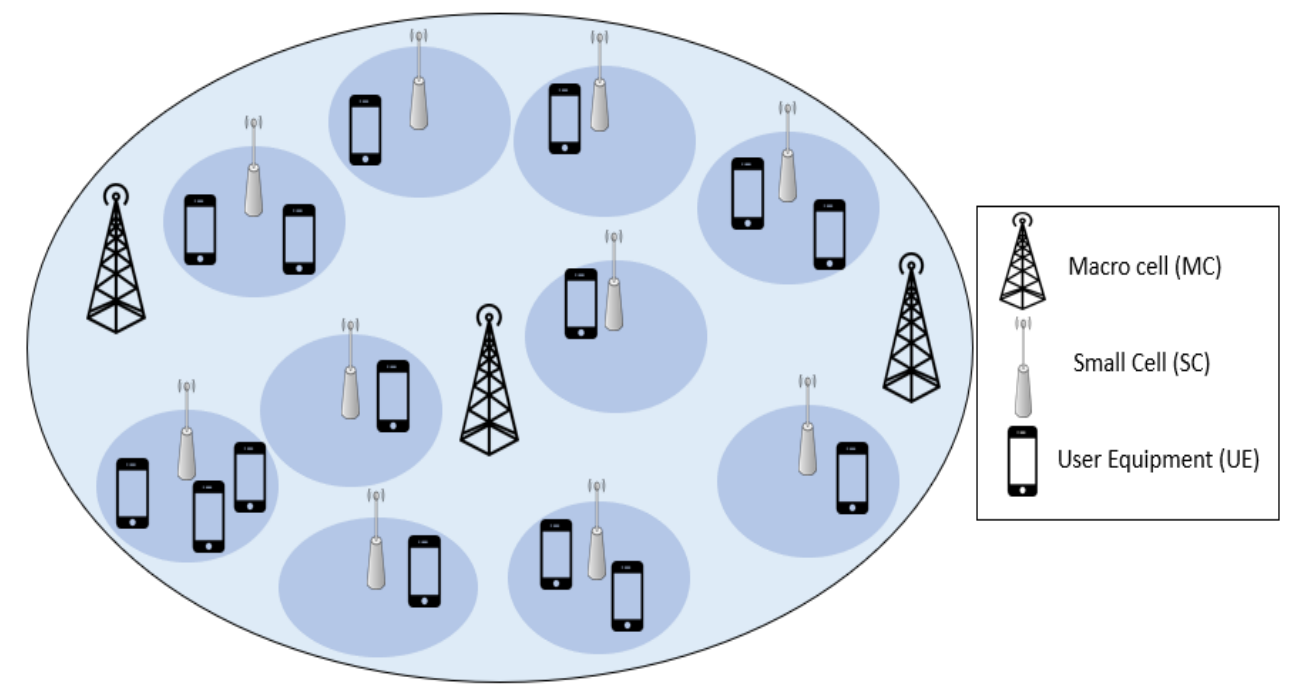
Figure 1. General representation of HetNet scenario with densely deployed small cells.